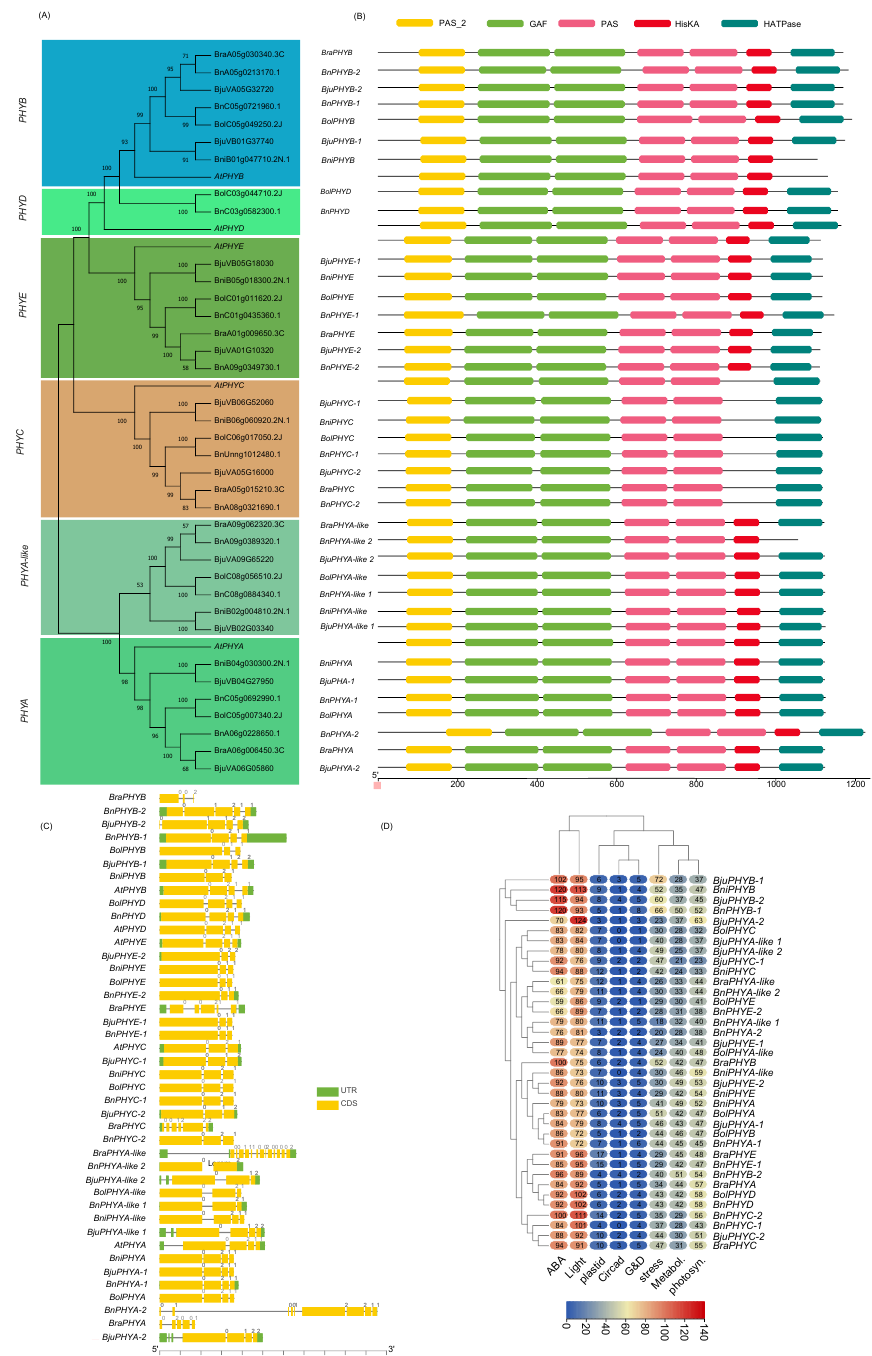
Figure 2. Phylogenetic analysis, classification, and structural description of phytochrome (PHY) gene family in Brassica species. ( A ) The unrooted phylogenetic tree was established with Arabidopsis and five Brassica species ( B. rapa , B. oleracea , B. nigra , B. napus , and B. juncea ) PHY protein sequences using the neighbor-joining tree method with 1500 bootstrap replications in MEGA11. ( B ) Represents the domain architecture of phylogenetically classified PHY genes of Brassica species, while ( C ) represents the gene structures including Intron/exon pattern and intron phases (Class 0, 1, and 2) and UTRs. ( D ) Heatmap represents the key cis-regulatory elements (ABA- and light-responsive, elements associated with plastids, circadian rhythm, growth and development (G&D), stress, metabolite biosynthesis, and photosynthesis) and their abundance in putative promoter motifs of Brassica PHY genes reported in this